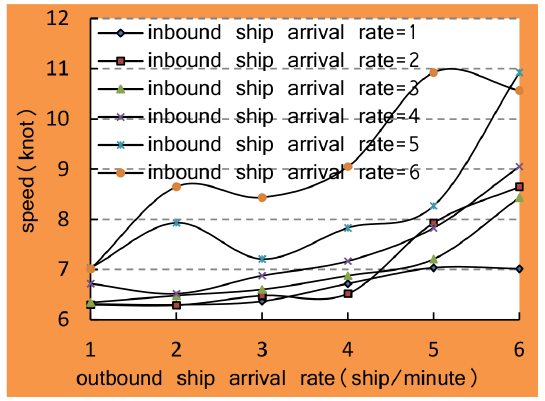
Figure 19. Average speed of waterway system and outbound ship arrival rate as a function at variable inbound ship arrival rate (when prohibit